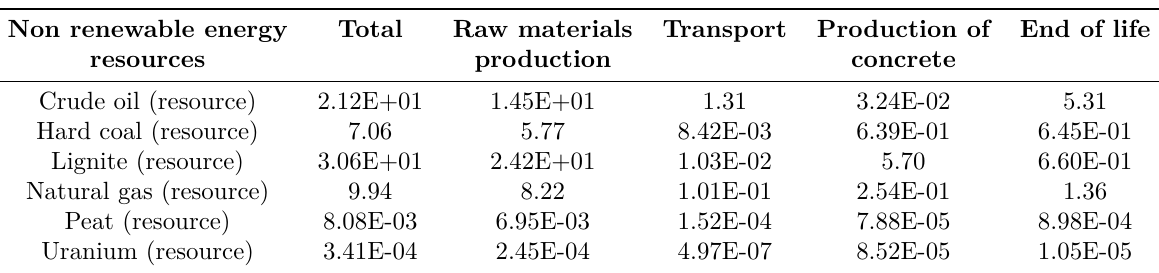
Table 2. Consumption of non renewable energy resources during life phases of 1 t of lightweight concrete block (consumption in